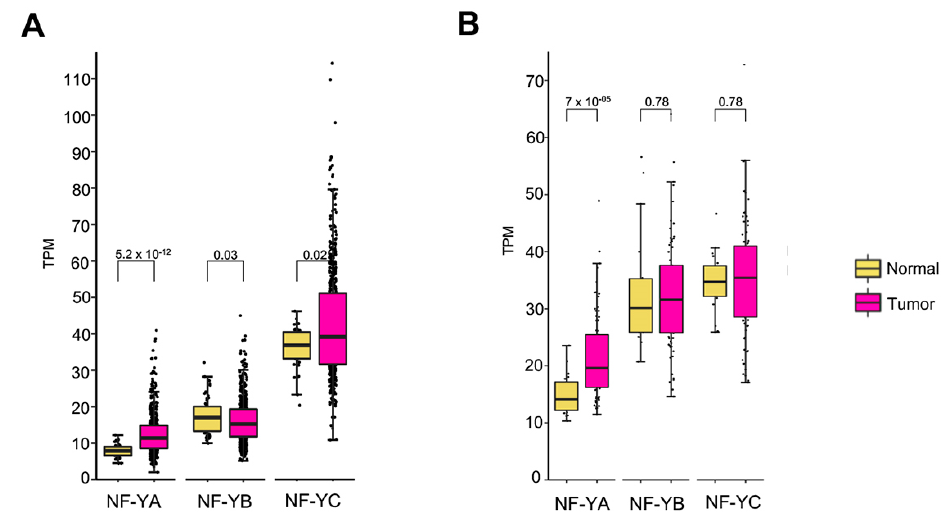
Figure 1. NF-YA is overexpressed in LUSC. ( A ) Box plots represent the expression levels of NF-Y subunits at gene level in the TCGA-LUSC RNA-seq dataset, measured in TPMs. ( B ) Expression of NF-Y subunits at gene level across the LUSC tumors of the GSE81089 dataset. P values are calculated using a Wilcoxon signed-rank test.